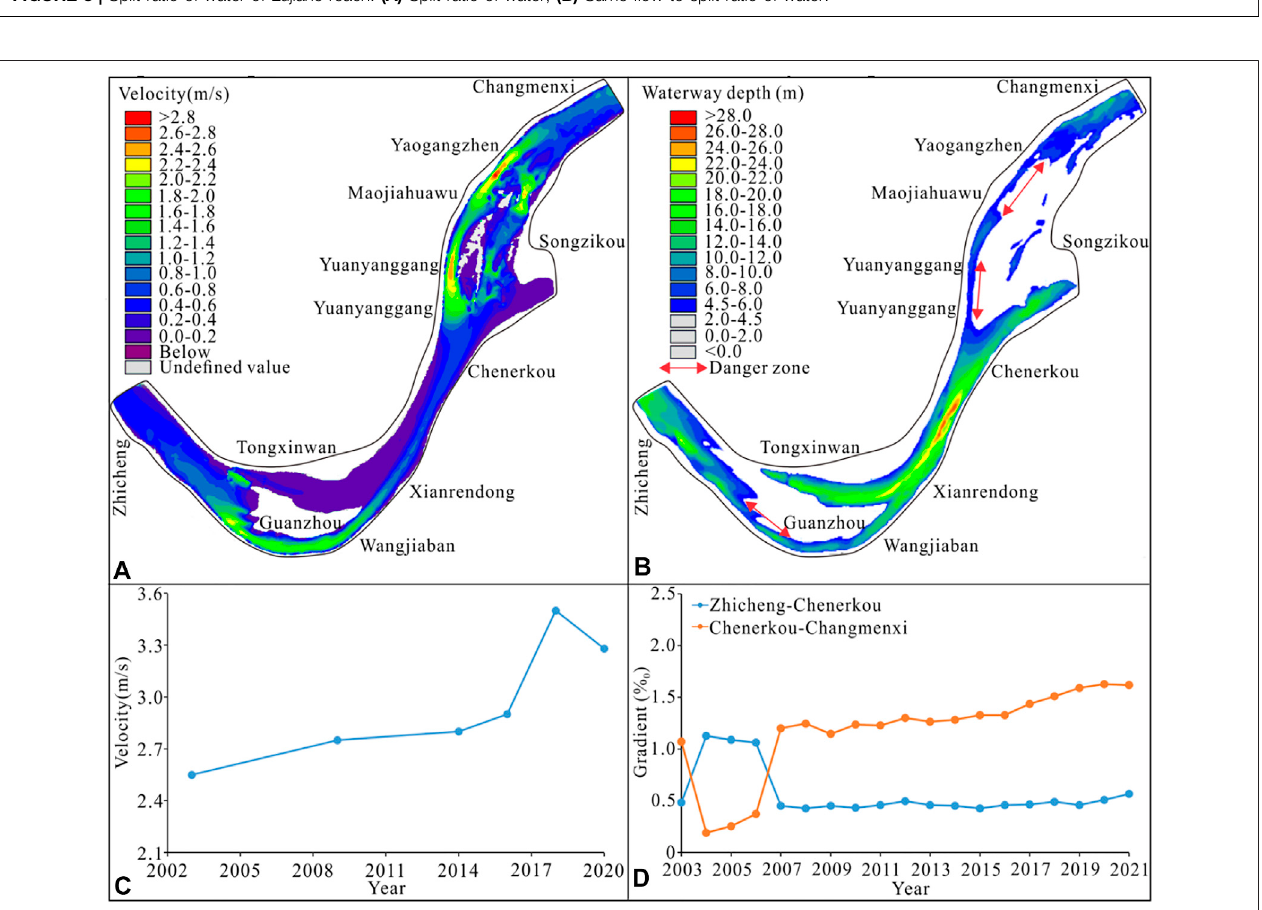
FIGURE 9 | Hydrodynamic and waterway changes in shunt area of Songzikou; (A) Velocity distribution; (B) Water depth; (C) Maximum velocity; (D) Maximum gradient.